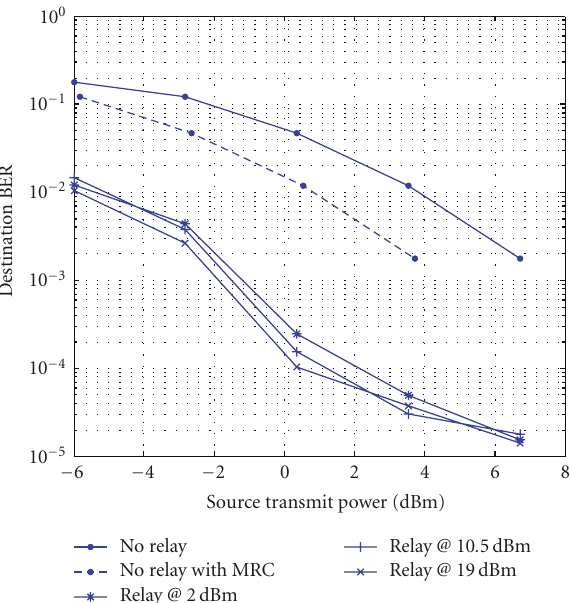
Figure 8: BER results for relay versus relayless links.